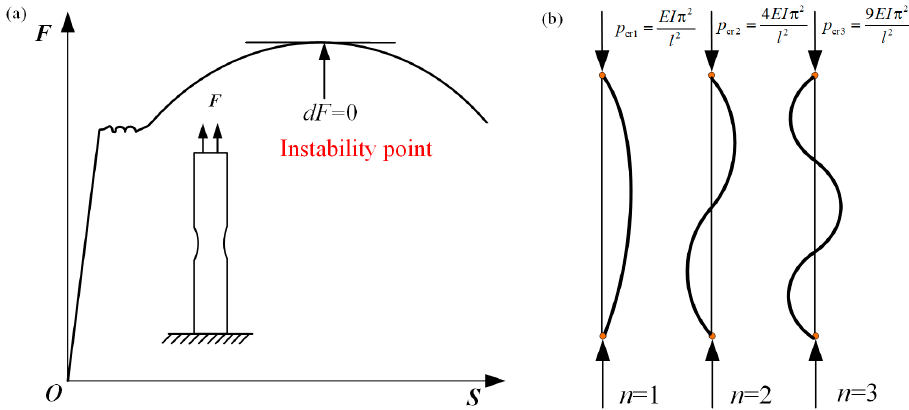
Figure 1. Types of plastic instability: ( a ) tensile instability; ( b ) compression instability [24]. Tensile instability includes dispersion instability and concentration instability. After the material undergoes stable and uniform deformation under tensile stress, there is a metastable flow in a relatively wide area, which is called dispersion instability. When the tensile necking reaches a certain extent, the unstable flow will be confined to a narrow area, which is called local instability or concentration instability. Swift proposed [28] that, for ductile work-hardening materials with uniform structure, the strain remains constant until a critical value is reached. At this point, the rate of decrease in the cross-sectional area is faster than the rate of increase in yield stress, causing the material to reach